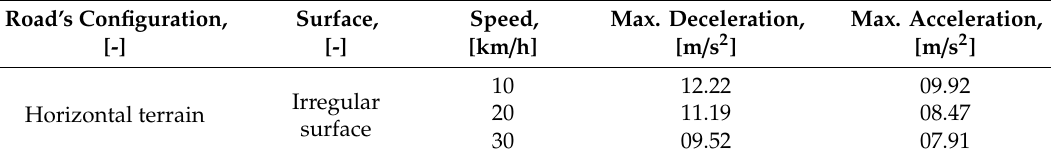
Table 3. Actual values recorded in practical tests of the experimental ATIRV with added load. Road’s Configuration, Road’s